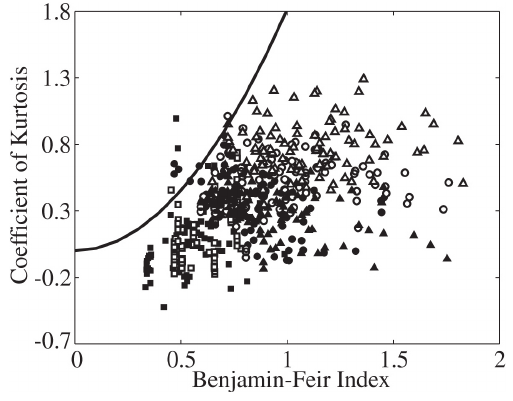
Fig. 6. Coefficient of kurtosis vs. BFI. Fig. 7. Scaled maximum wave height vs. coefficient of